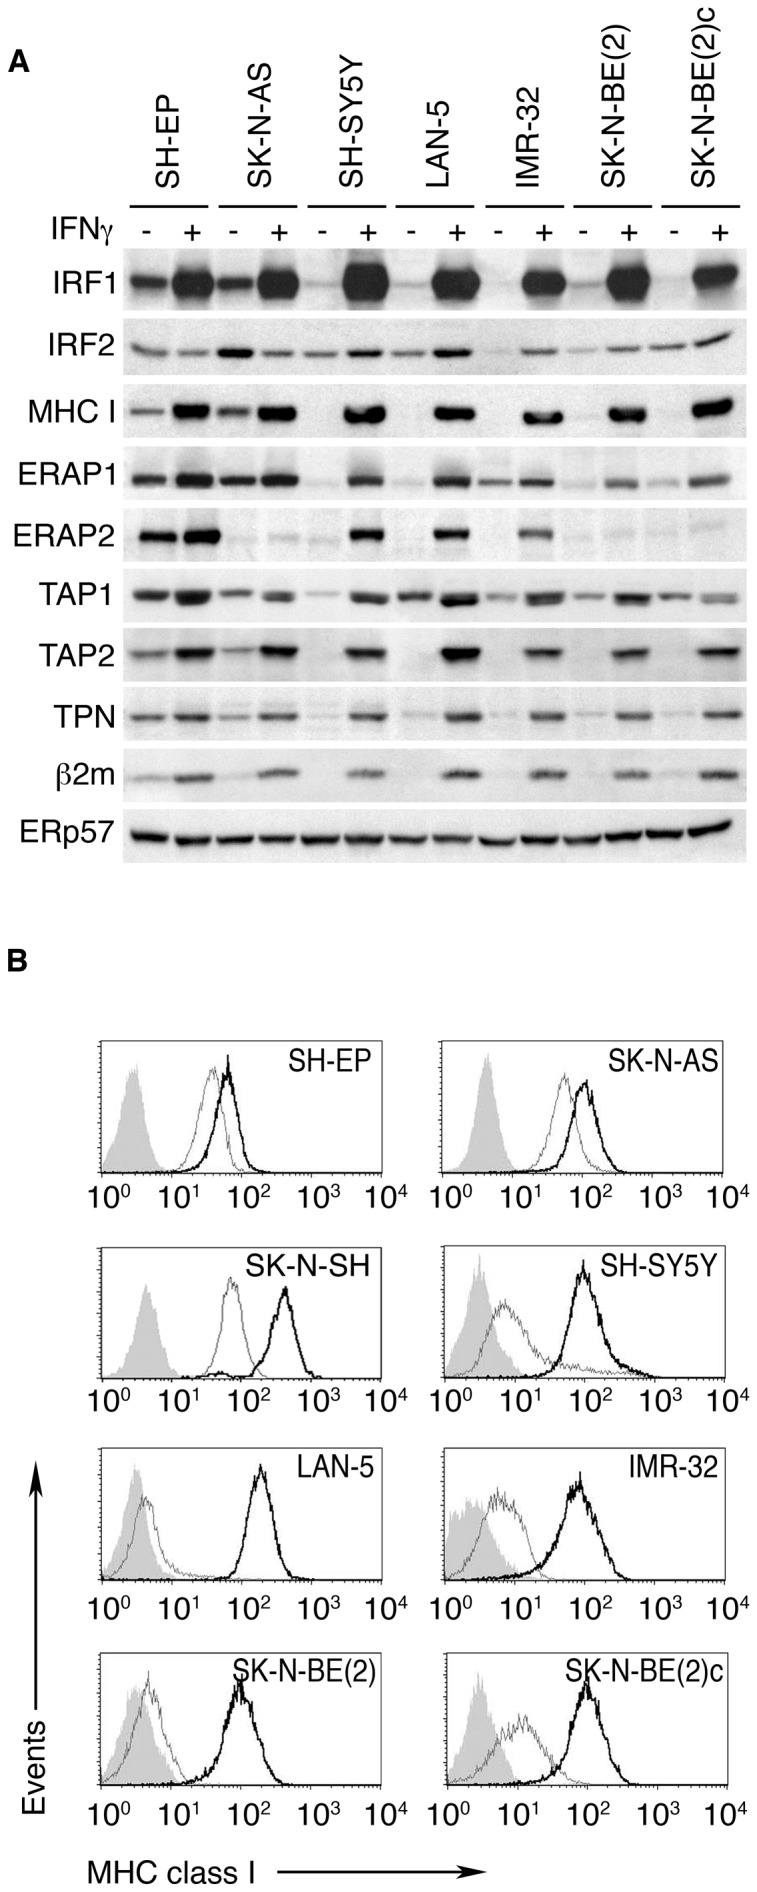
IFN-γ restores IRF1, MHC-I and APM components in NB cell lines.A, whole-cell lysates of NB cell lines cultured for 48 hours in the presence and absence of IFN-γ were resolved by SDS-PAGE and Western blotted with specific antibodies. ERp57 was used as loading control. Densitometric and statistical analysis of WB bands are shown in Fig. S4. B, flow cytometry analysis with mAb W6/32 of surface MHC-I expression of NB cells grown, as above, for 48 hours in the presence and absence of IFN-γ. Untreated cells (grey lines), treated cells (black lines) and isotype-matched negative controls (shaded histograms) are shown. Data shown in panels A and B are representative of 3 and 5 independent experiments, respectively.